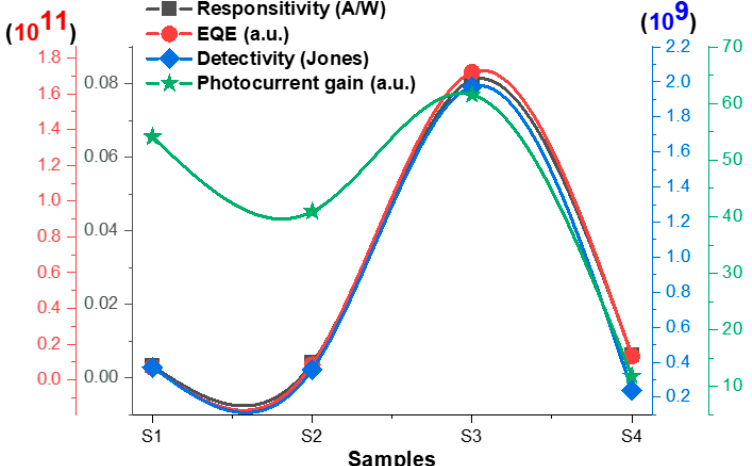
Figure 15. A relation between the responsitivity, EQE, detectivity, and photocurrent gain of each sample: S1, S2, S3, and S4.